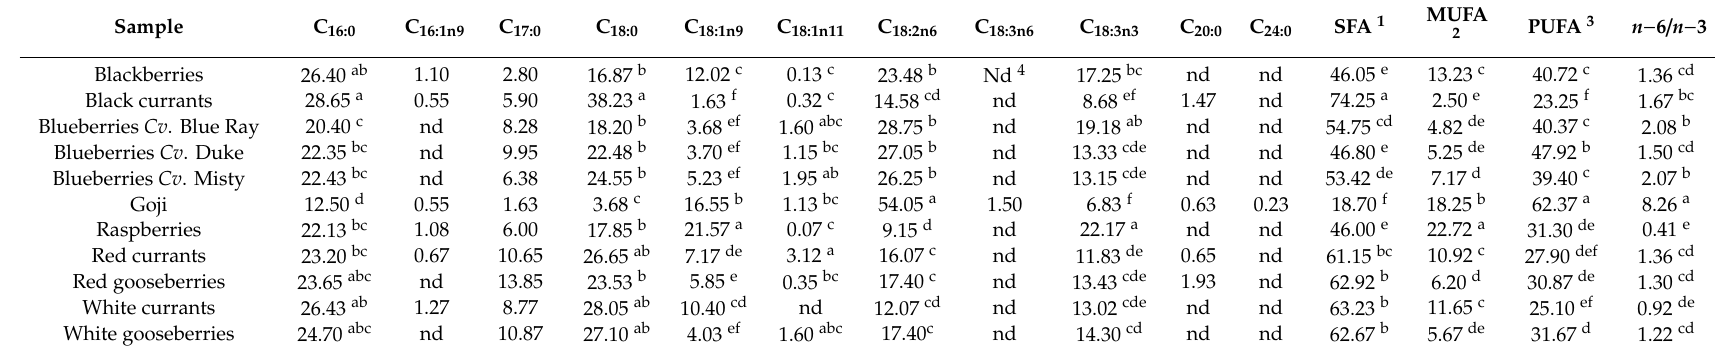
Table 5. Fatty acid composition of the berries (g / 100 g total fatty